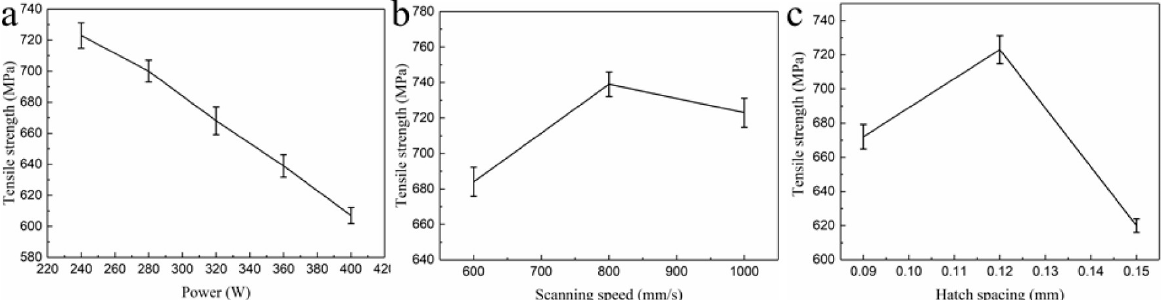
Figure 9. Effect of process parameters on the tensile strength: ( a ) power, ( b ) scanning speed, ( c ) hatch spacing [71].